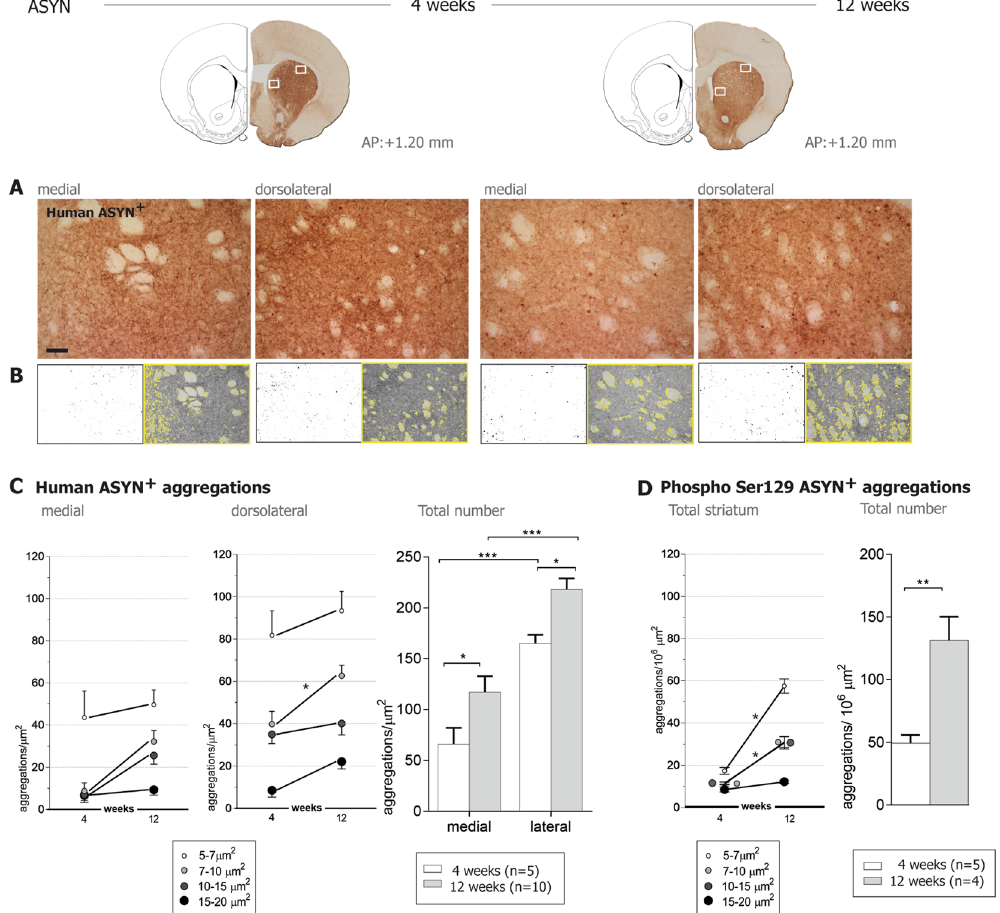
Figure 5. Quantification of ASYN + aggregates in striatum. Upper row shows an example of the striatal sections immunostained against human ASYN and the representative areas at the medial and dorsolateral striatum that were photographed (shown in A ) and used for the quantification of ASYN + inclusions in striatal fibers. ( B ) Illustrates the quantification method: left panels show masks of inclusions > 5 µ m 2 generated by a grey scale threshold in the software ImageJ. The area covered by ASYN + immune-reactivity was segmented from the myelin-rich areas (showed by the yellow outline in the right images) and used for normalization. ( C ) Show numbers of ASYN + swellings per µ m 2 by size and total numbers per area and time (4 weeks n = 5, 12 weeks n = 10). Dorsolateral striatum exhibited more ASYN + aggregates than the medial striatum; but the number of aggregates increased with time in both areas. Two-Way ANOVA (Total number, time effect F(1,26) = 12.41 P = 0.001; area effect F(1,26) = 45.94 p < 0.0001) followed by Sidak’s multiple comparisons. ( D ) Analysis of Ser129 phosphorylated ASYN (ASYN S129) + inclusions in the total striatal area revealed a significant increase of small and medium-sized ASYN S129 + with time, but not of the big ones (15–20 µ m 2 ). Two-Way ANOVA (Dorsolateral, Interaction Time&size F(3,28) = 7.88 P = 0.006, time effect F(1,28) = 60.04 P < 0.0001; size effect F(3,28) = 17.54 p < 0.0001) followed by Sidak’s multiple comparisons. In the right graph, total number of ASYN S129 + aggregates increased with time (Unpaired t-test F (3,4) = 6.534, P = 0.002). Notice fewer total ASYN S129 + aggregates were found per µ m 2 compared to ASYN + aggregates (see scale difference in y axis in C and D ), thus only a small portion of ASYN + accumulations contained S129 phosphorylated ASYN. * P < 0.05, ** P < 0.01. Scale bar = 60 µ m applies to all. Brain sections drawings are modified from Paxinos & Watson, The rat brain in stereotaxic coordinates (with permission Academic